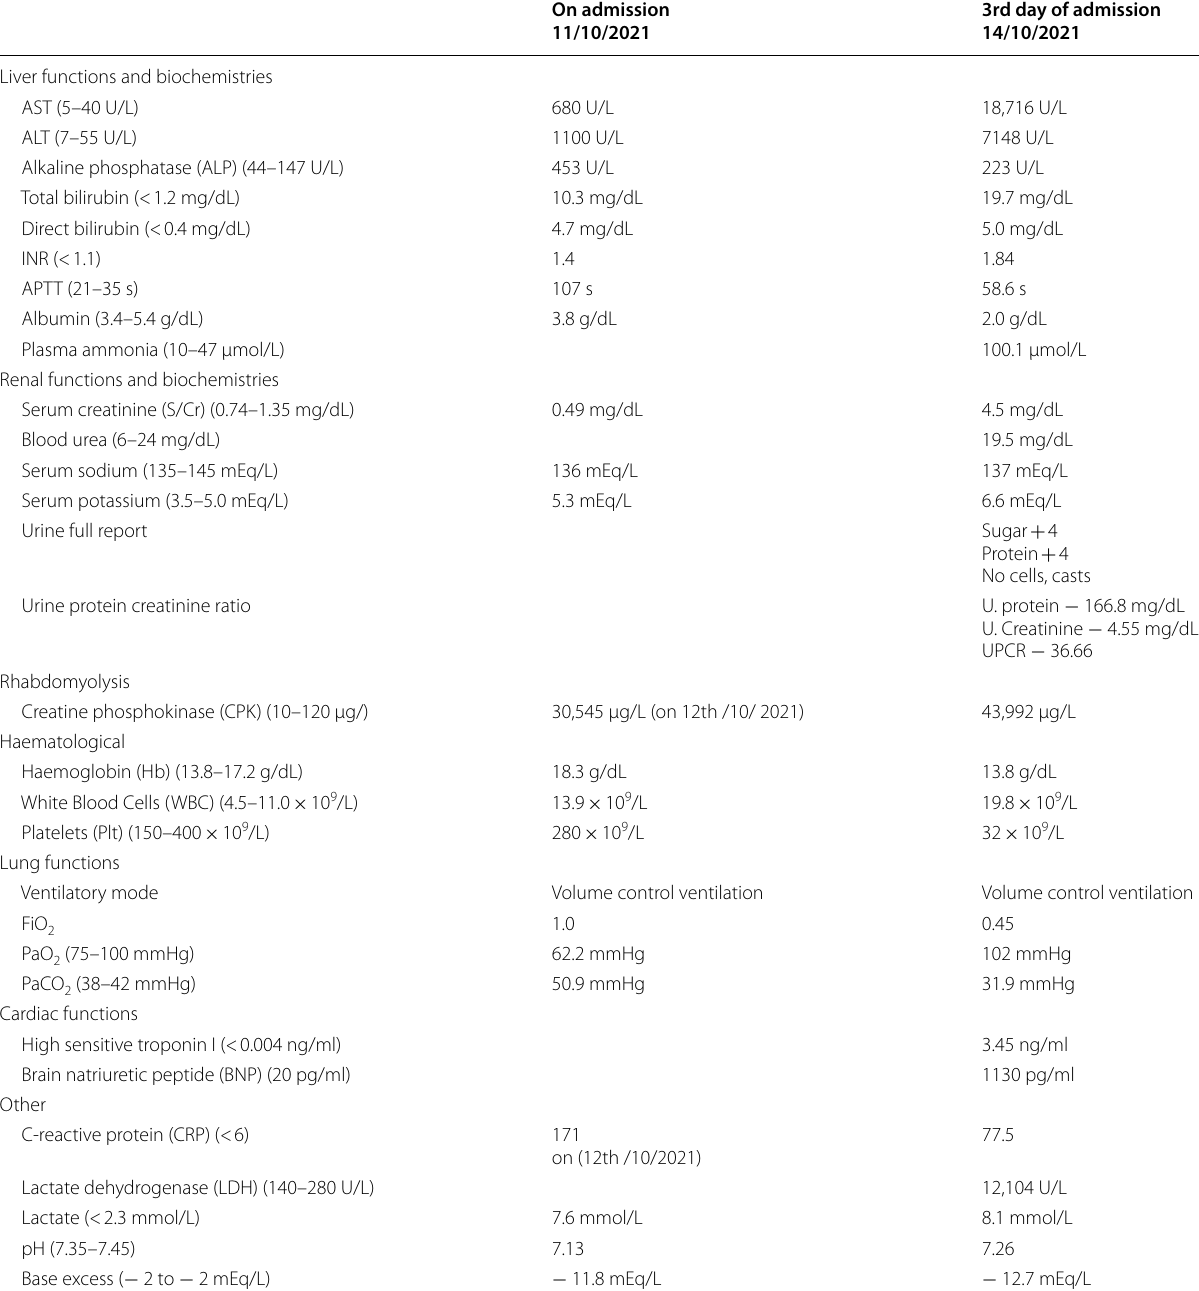
Table 1 Progression of biochemical parameters of organ injury over the 1st 3